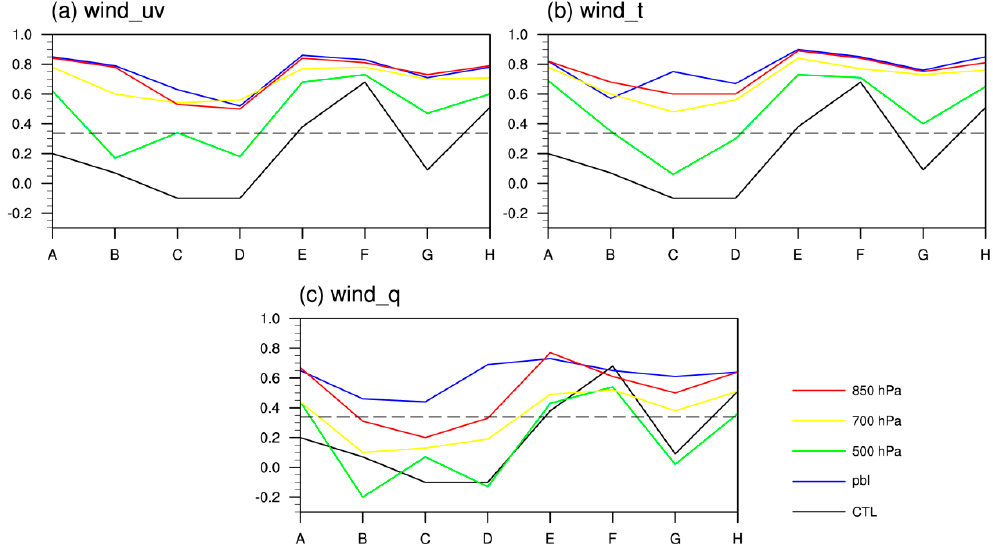
Figure 8. The variation of CC between the simulated and observed 2 m wind with sub-regions A–H when various nudged levels were adopted (the dashed line indicates the CC threshold of significance t test at 0.1% significance level): ( a ) nudging uv; ( b ) nudging θ ; and ( c ) nudging q.